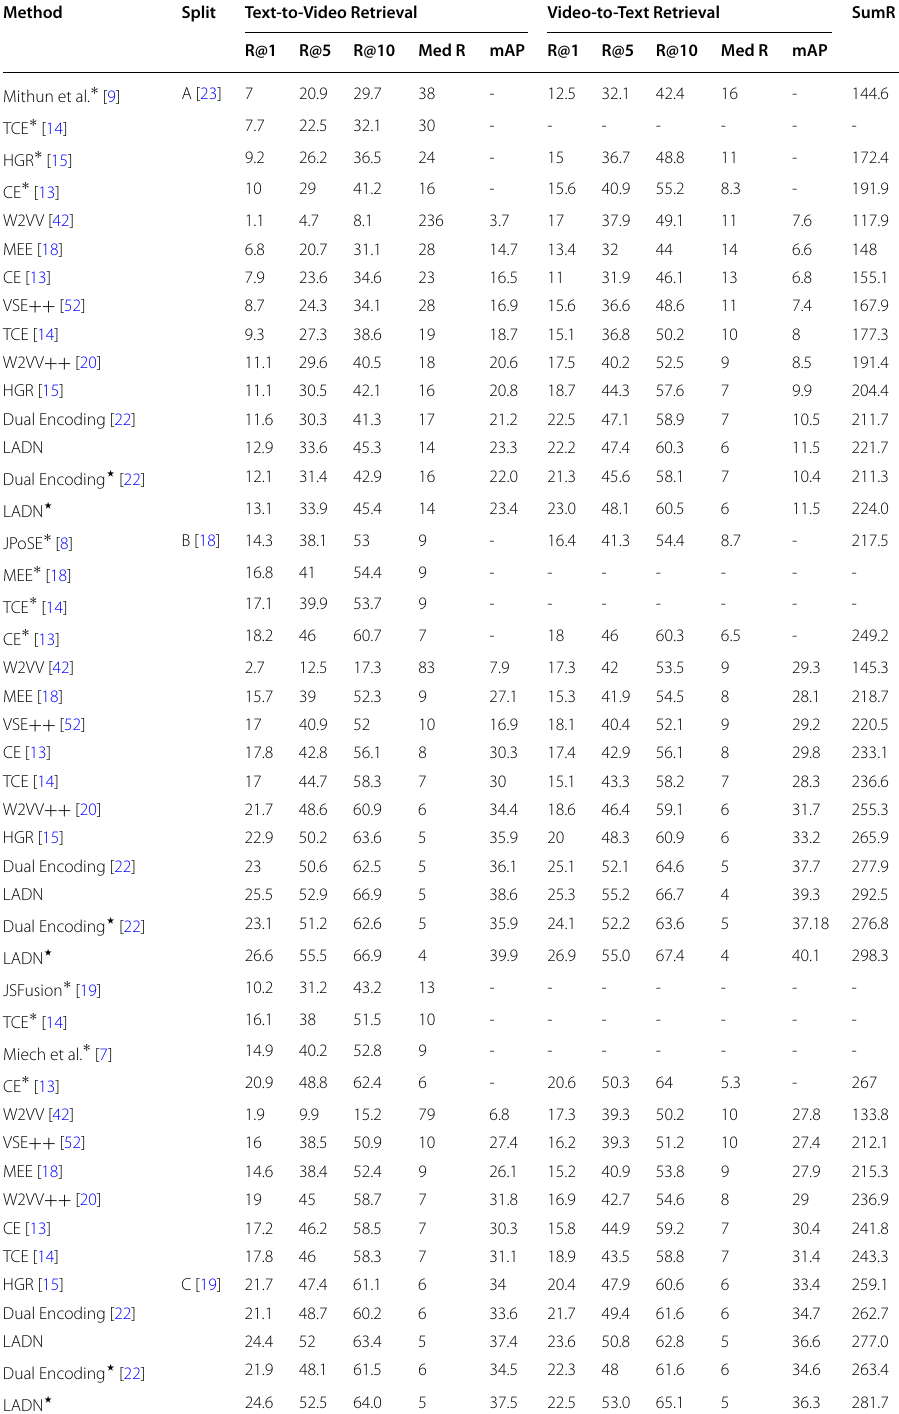
Table 1 Experimental results on MSR-VTT. We utilize three split methods as A [23], B [18], and C [19], respectively. Larger R@k, mAP, and lower Med R denote better